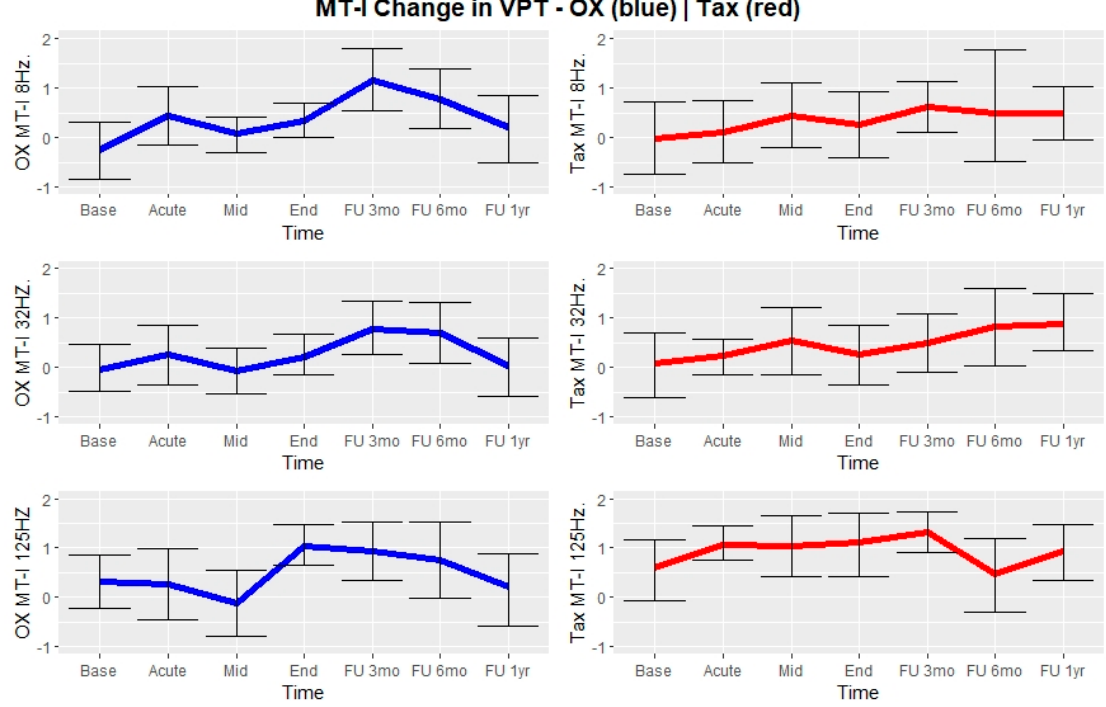
Figure 3. Development of mean VPT Z-scores taken from patient’s dominant metatarsal I (palmar surface) from baseline to 1 year after end of treatment including the acute measurement taken once between day 3 and 5 in the 1 course of chemotherapy. Error bars represent 95% Confidence intervals of mean VPT Z-scores. Left, blue: Depicts patients in CAPOX treatment. Right, red: Depicts patients in Carbo-Tax treatment.